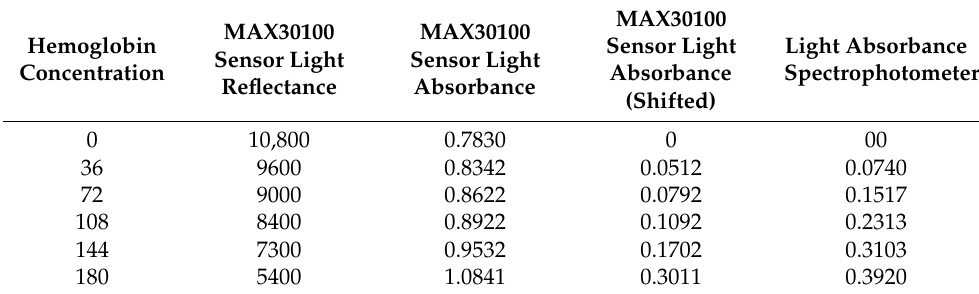
Table 2. Light absorbance values from all